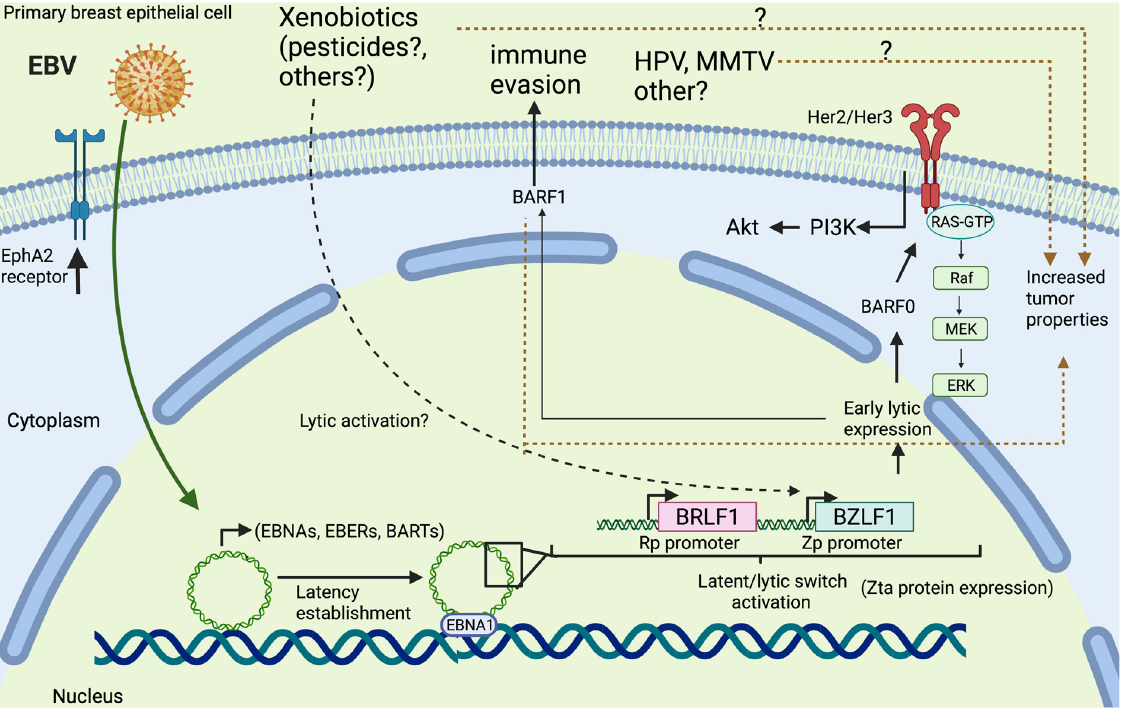
Figure 3. A hypothetical model of EBV role in breast carcinogenesis. Primary breast epithelial cells are susceptible to EBV infection, probably using EphA2 receptor. Once EBV latency is established, including EBNA-1, EBER and BART expression, the lytic switch can be activated. Xenobiotics may be involved in Zp activation as suggested in some models. BARF0 is involved in Her2/Her3 activation promoting tumor transformation by Ras/Raf/MEK/Erk and Pi3K/akt signaling pathways. BARF1 is involved in immune evasion and providing tumor properties. Xenobiotics or additional viral infections can cooperate with EBV for increasing breast tumor properties.